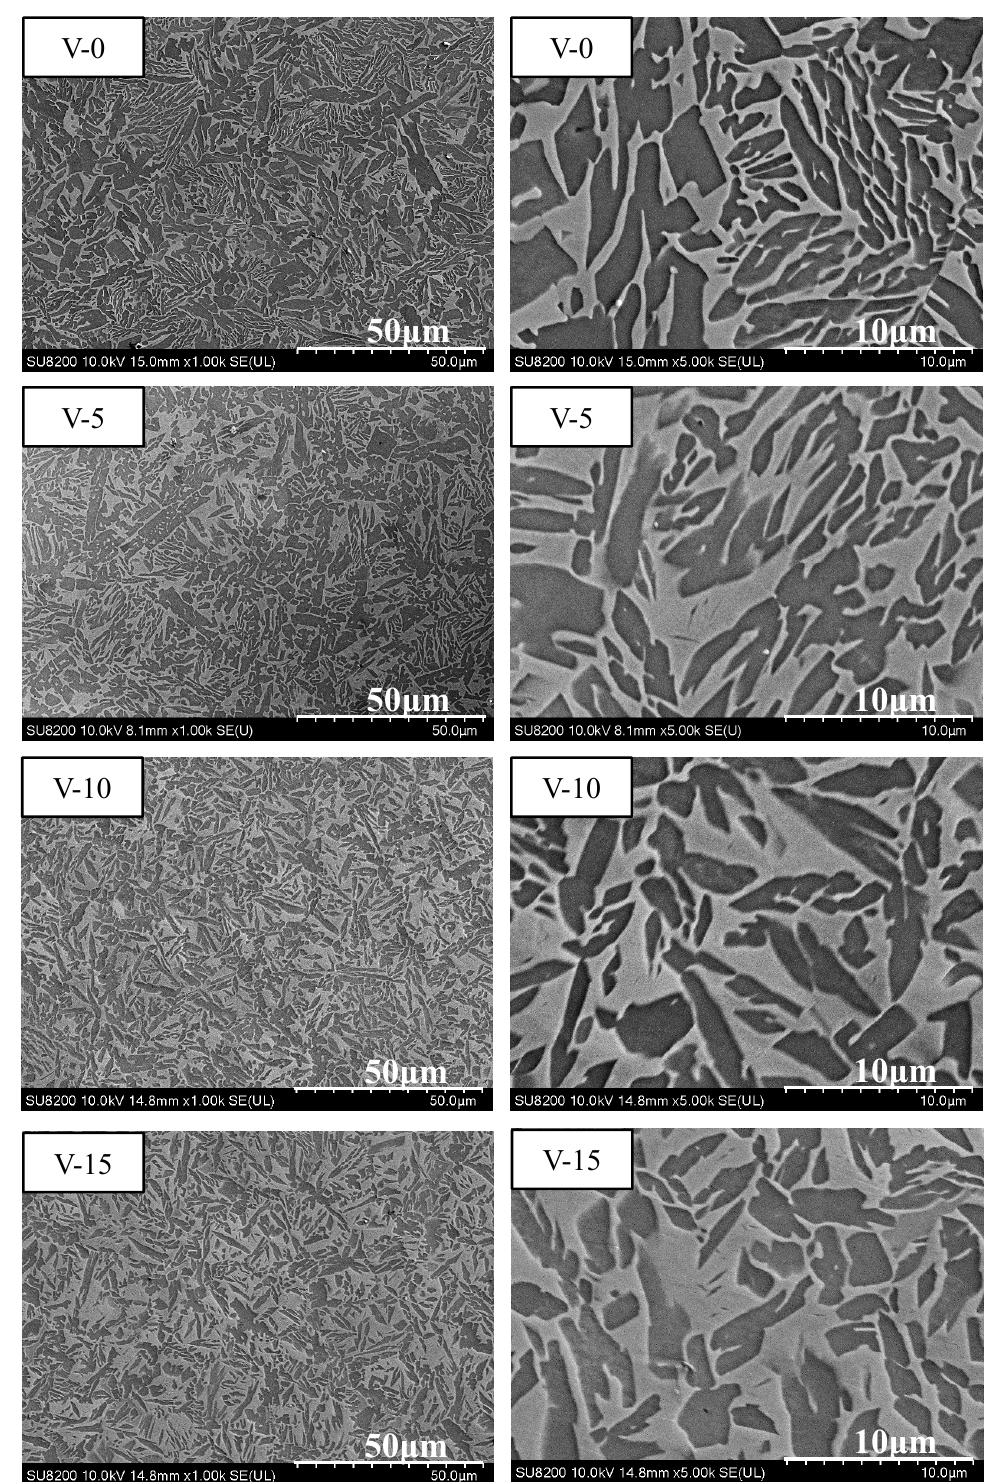
Figure 7. SEM images of the Al 50 (TiCrMn) 50-x V x (x = 0, 5, 10, 15) alloys.